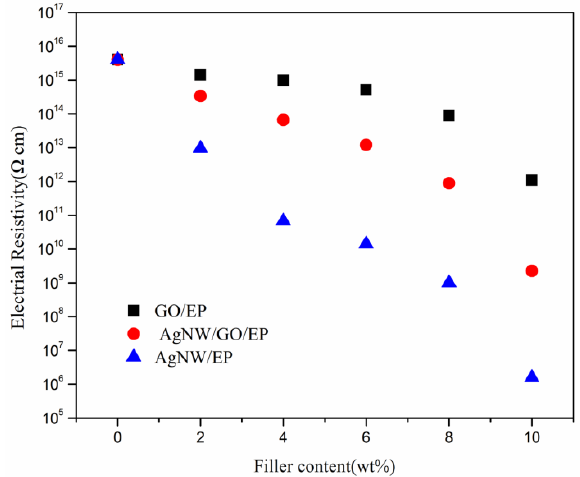
Figure 7. Electrical resistivities of GO/epoxy resins (EP), AgNW/GO/EP, and AgNW/EP composites.